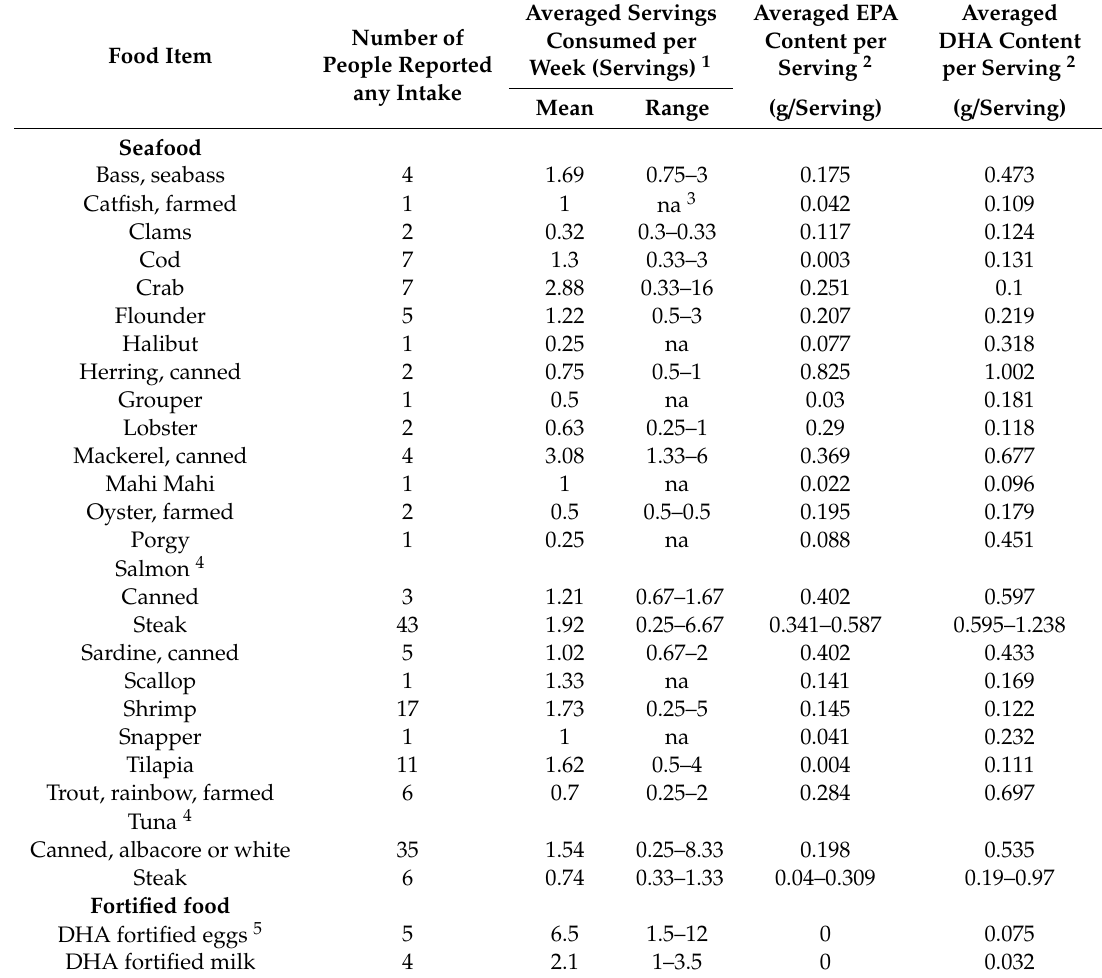
Table 2. Frequency of consumption of seafood and omega-3 fatty acids fortified food